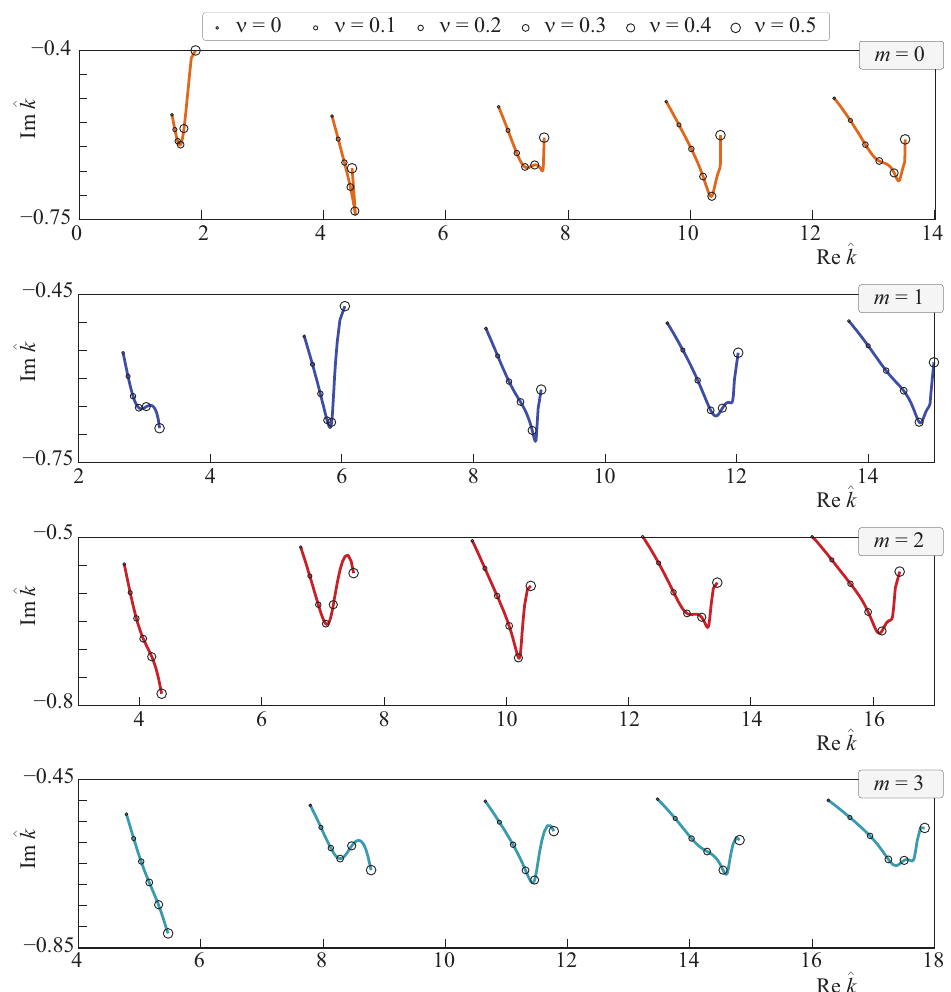
Figure 9. Eigenfrequencies ˆ k m n for a circular crack in an elastic space with Poisson ratio ν